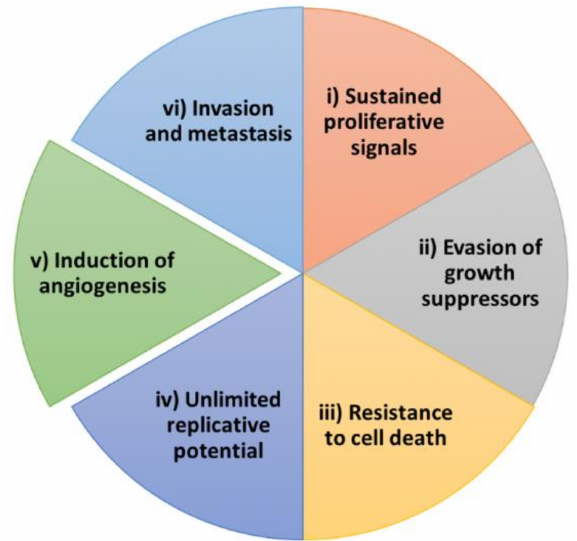
Figure 2. Hallmarks of cancer. The six hallmarks of cancer described by Hanahan and Weinberg in 2000 [13]. The issue was revisited in 2011 [14], when four new hallmarks (not shown in the figure) were added to the list. In 2022, the list of hallmarks has increased up to 14 [19]. Table 1. Some of the most used assays to study angiogenesis and/or new modulators of angio- genesis in vitro, ex vivo, and in vivo. EC: endothelial cells; MTT: 3-(4,5-dimethylthiazol-2-yl)-2,5- diphenyltetrazolium bromide; ECM: extracellular matrix; MMP: matrix metalloproteinase; CAM: chorioallantoic membrane